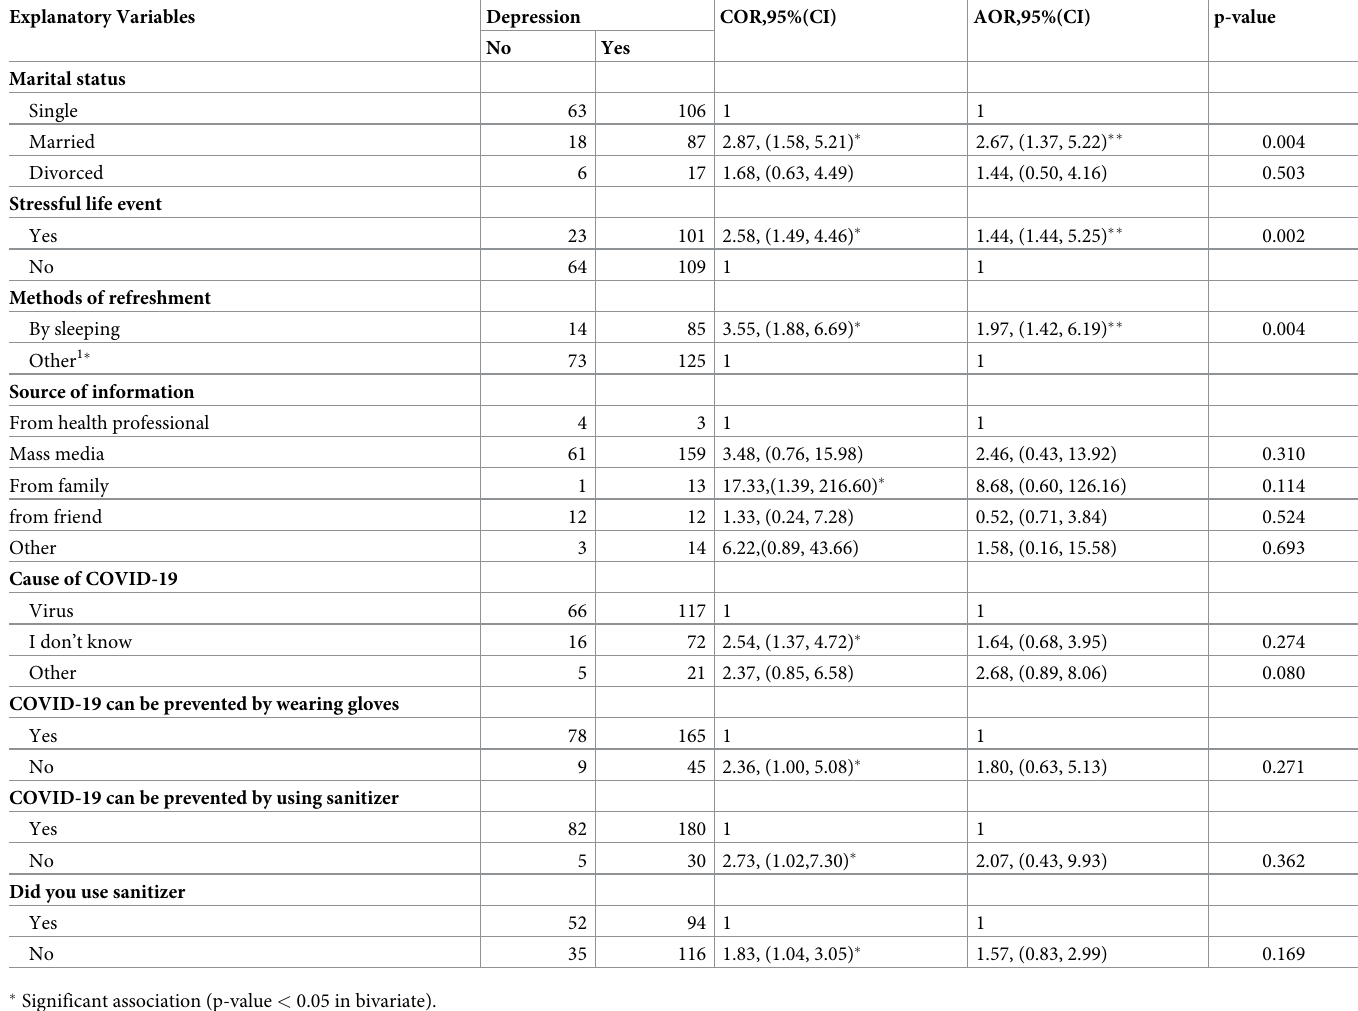
Table 5. Factors associated with depression among individuals under quarantine during the COVID-19 pandemic, in Addis Ababa, Ethiopia,